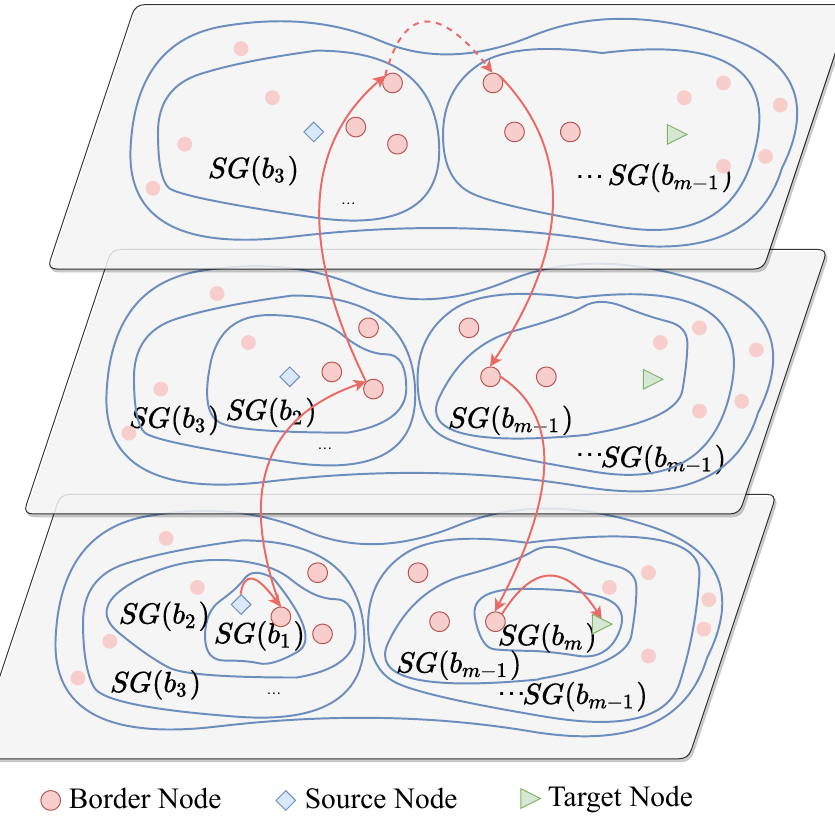
Figure 7. An illustration of the shortest path finding in the BVCP